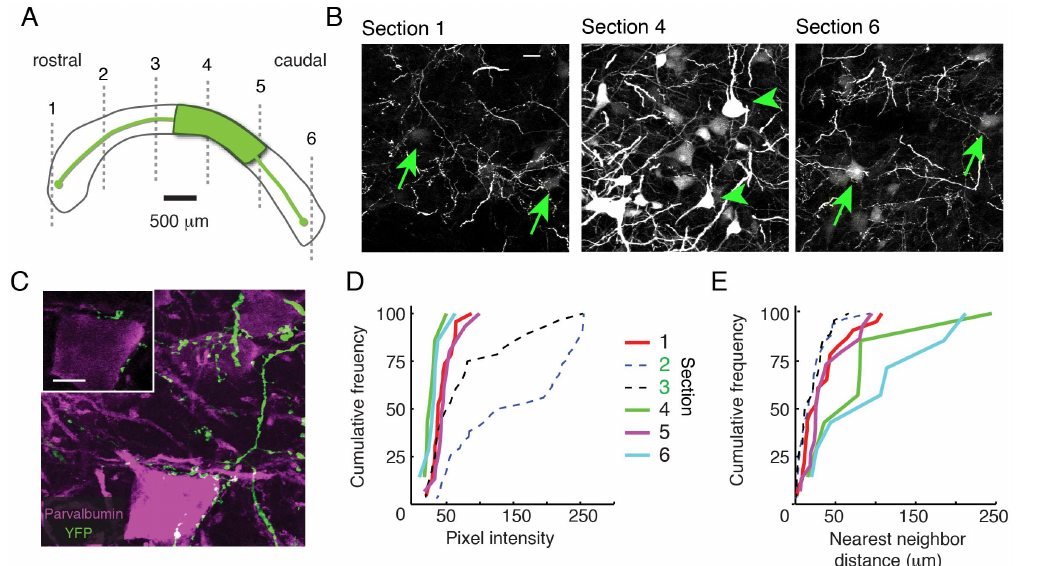
Figure 4. Long-range axonal projections and retrograde labeling within the Imc invivo . A) Schematic showing the location of injection of A3V expressing eGFP (green) in the horizontal plane. Grey, dashed lines represent the locations of the transverse sections shown in the following panels. B) eGFP-labeled axons and somata in transverse sections across the rostrocaudal extent of the Imc. Green arrows indicate retrogradely labeled somata observed at the rostral and caudal poles of the Imc (Sections 1 and 6). Green arrowheads indicate directly labeled somata observed only near the injection site (Section 4). C) Maximum projection confocal image of eGFP-labeled boutons (green) surrounding a parvalbumin-immunostained Imc somata (purple). Inset (upper left): single plane confocal image showing close apposition of an eGFP-expressing axon and the Imc soma shown in the full image (bottom right). D) Quantification of pixel intensity for somata at various locations across the rostrocaudal extent of the Imc. Each line represents distribution from a particular section in the transverse plane. A majority of neurons near the injection site (dashed lines) exhibited high eGFP expression, as indicated by high pixel intensity, while those at the distal ends consistently exhibited lower intensity (solid lines). E) Quantification of density of labeled somata at various locations across the rostrocaudal extent of the Imc. The distance of the nearest labeled neighbor was determined for each neuron in a field of view. Neurons near the injection site (dashed lines) had close near-neighbors, suggesting a dense distribution of labeled neurons. Neurons at the distal ends (solid lines) had more distant near-neighbors, suggesting a sparse distribution of labeled neurons.